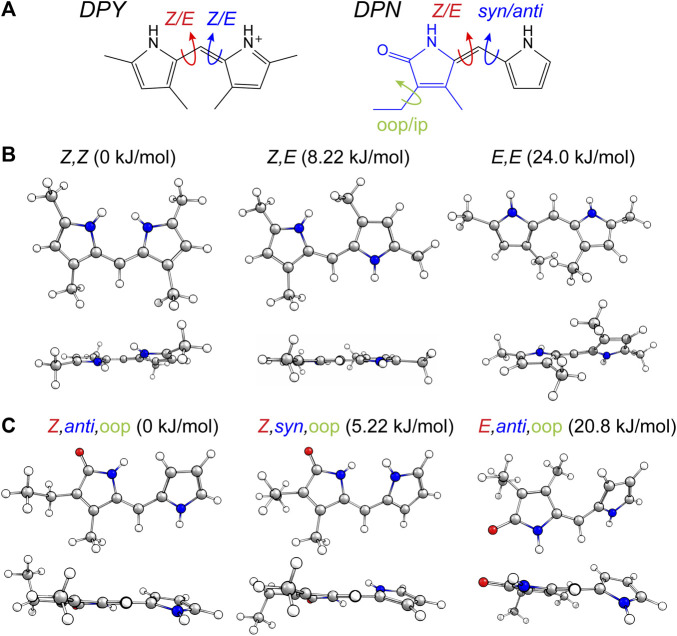

(A) Conformational degrees of freedom for DPY and DPN. (B,C) Calculated conformers of (B) DPY and (C) DPN with associated relative Gibbs free energies.